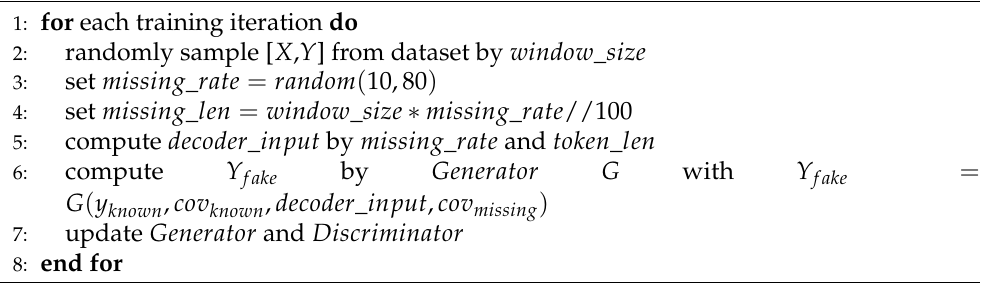
Algorithm 1 GAN training process based on random missing